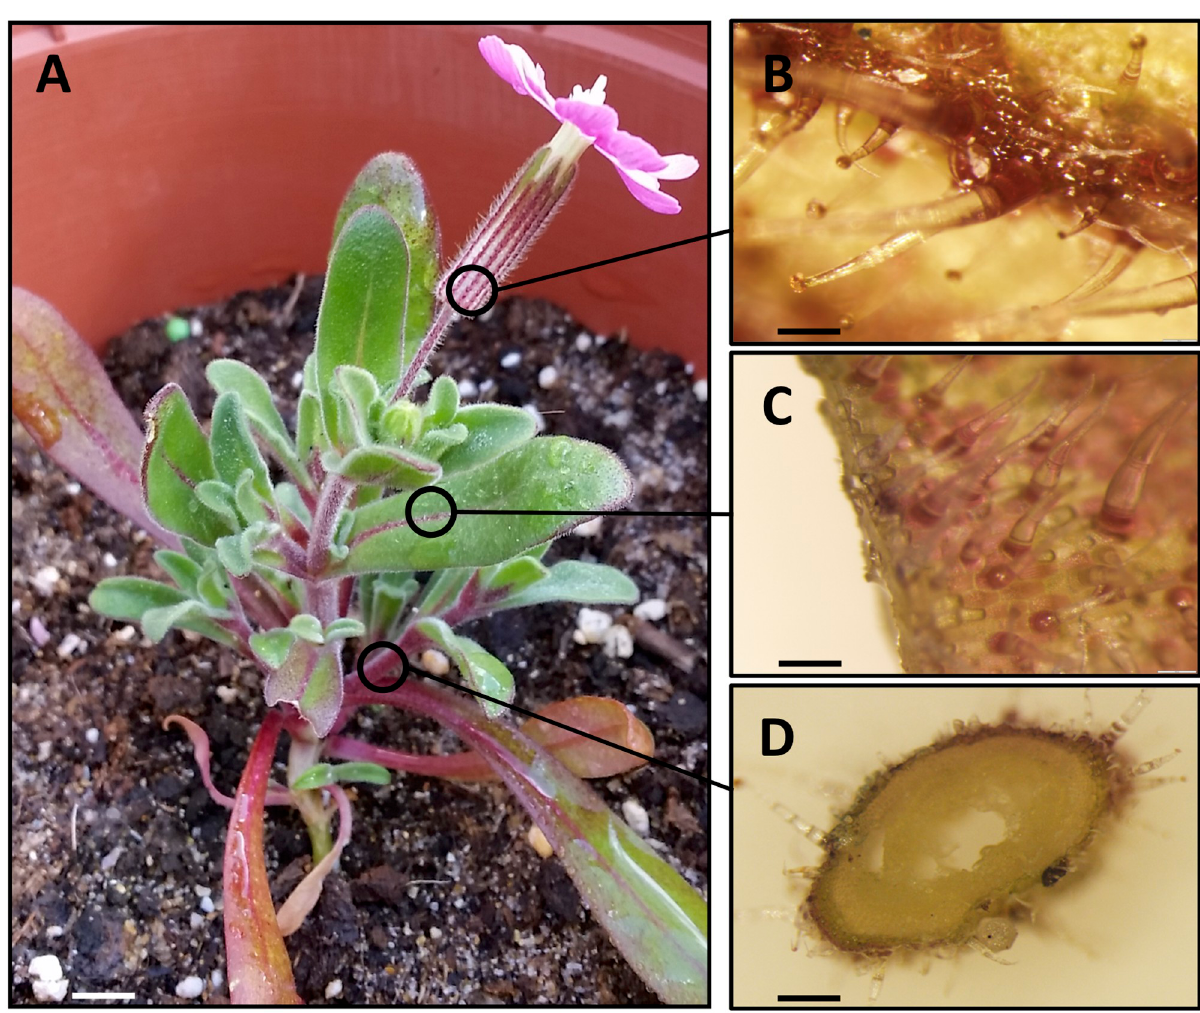
Fig 1. Detailed view of a Silene littorea plant (A) showing the accumulation of anthocyanins throughout the whole plant. Stereo-microscope photographs show pigments in the surface of the calyx ribs (B), adaxial surface of the leaf (C), and cross section of a stem (D). Scale bars: 5 mm (A), 0.5 mm (B, C), and 1 mm